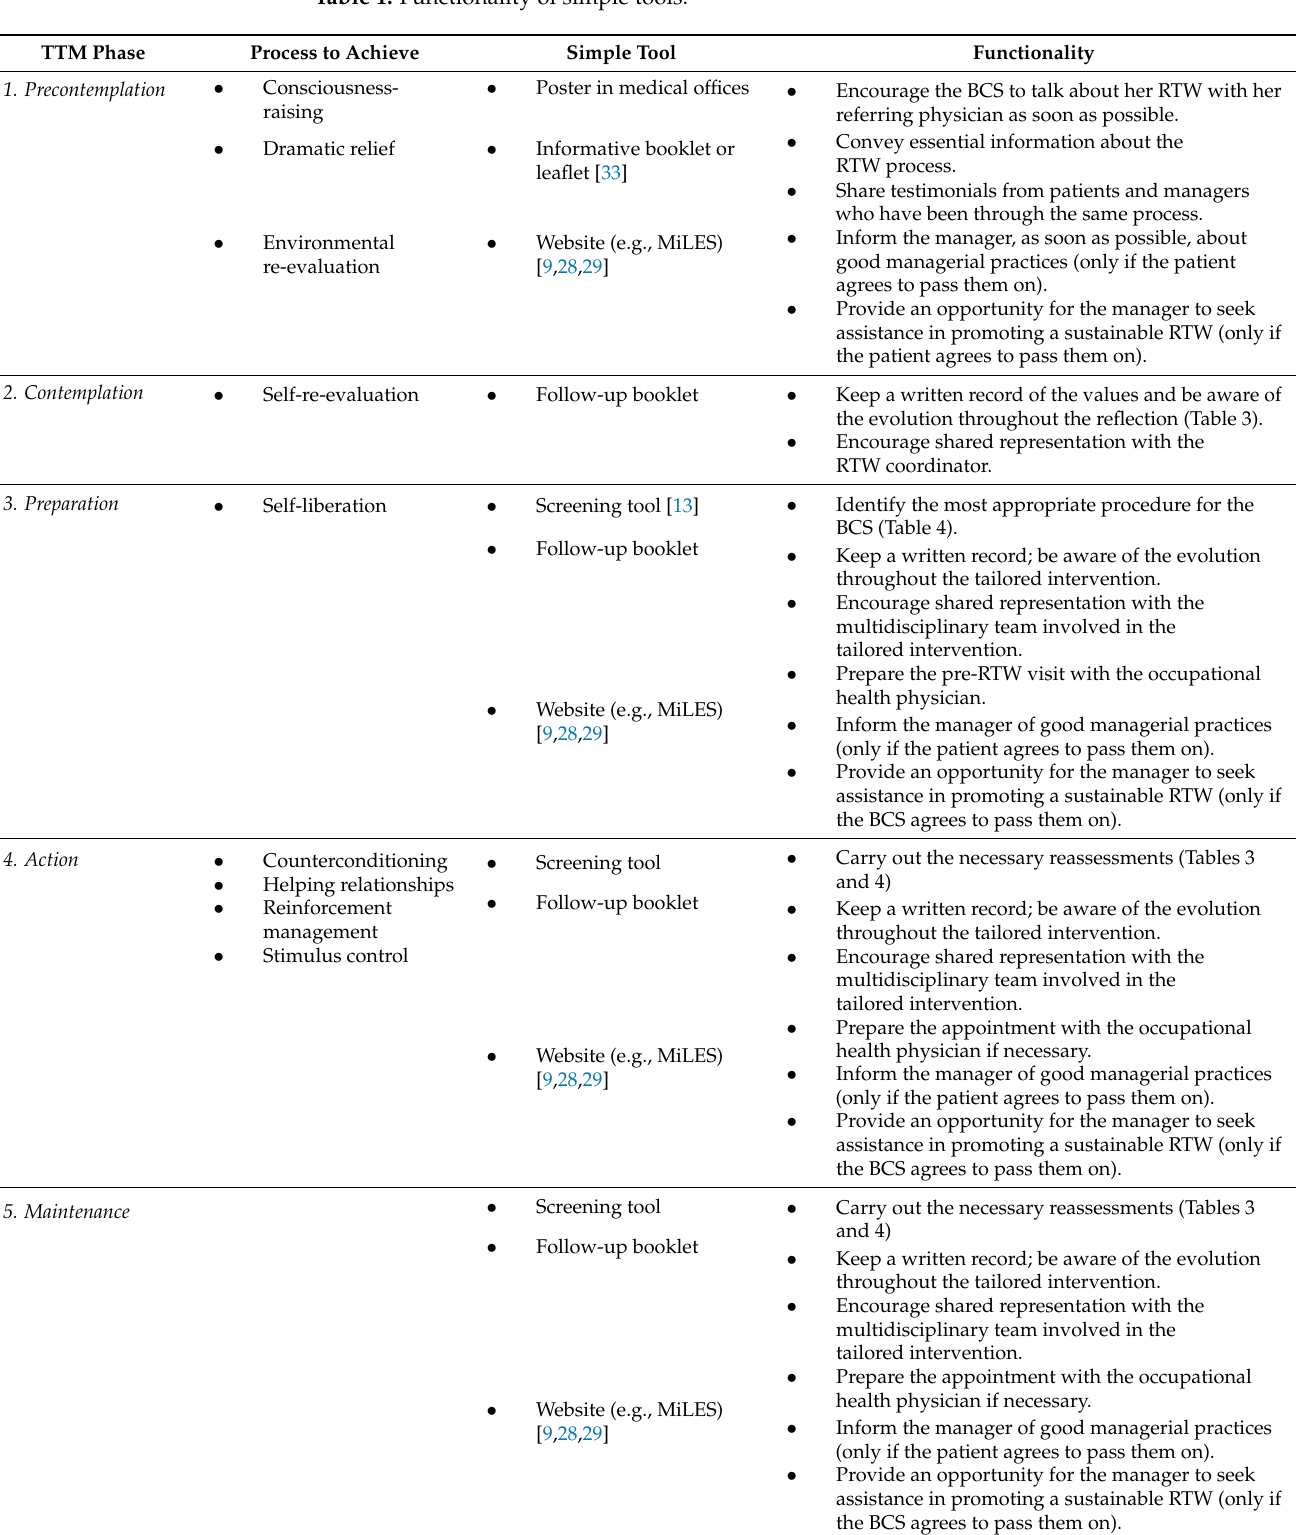
Table 1. Functionality of simple